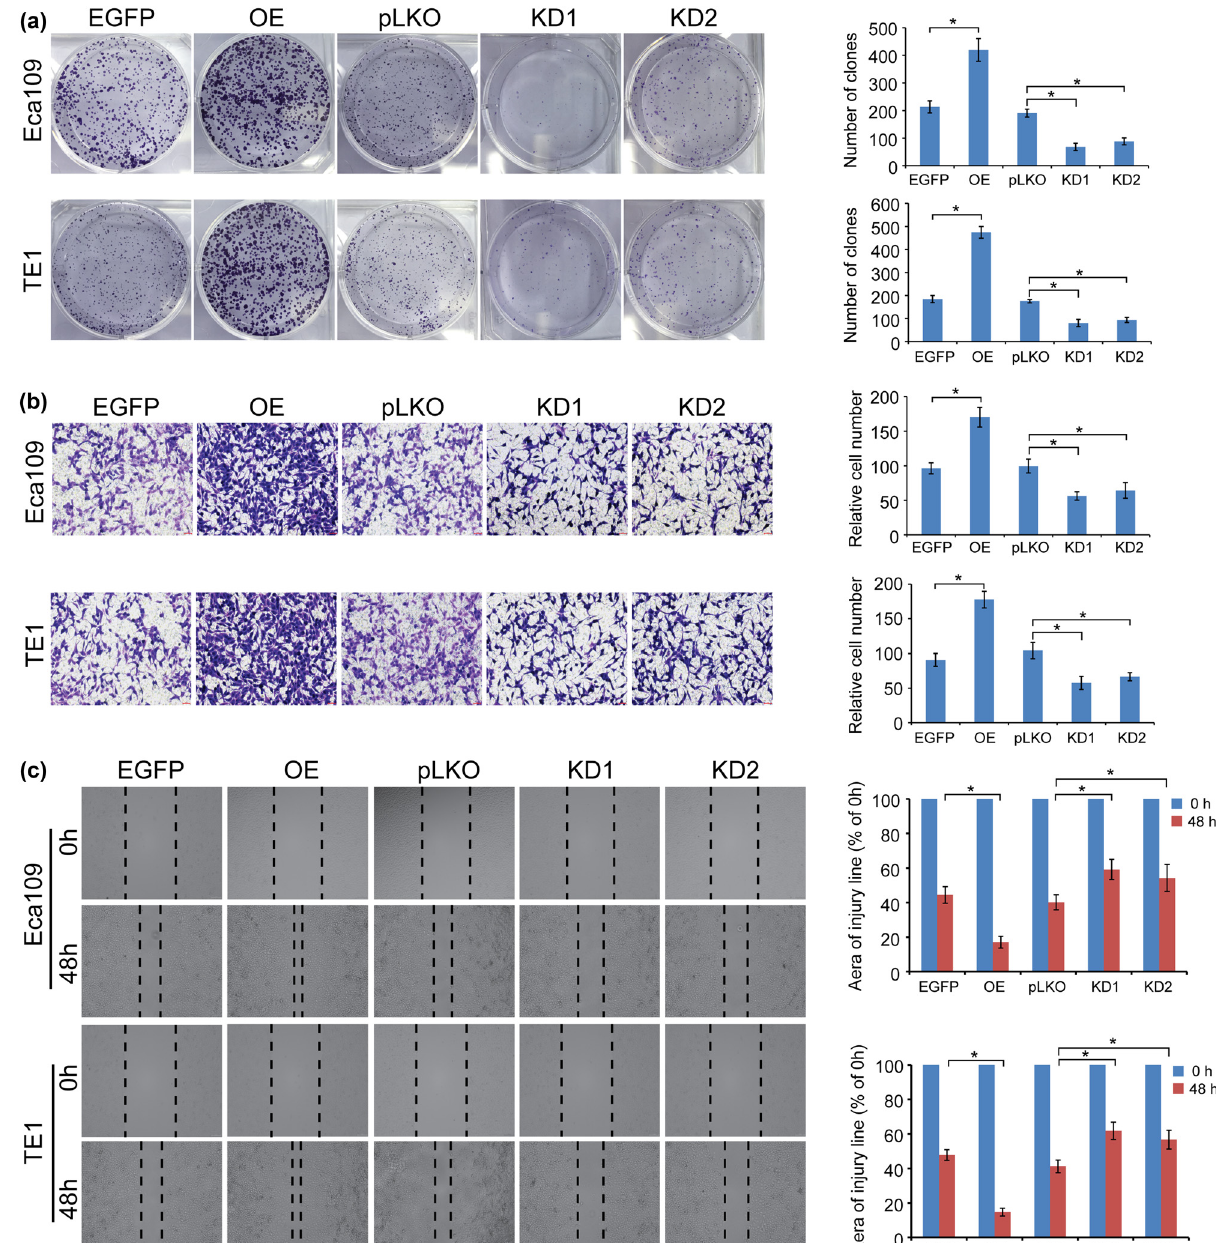
Figure 2: High expression of TET3 promotes the viability and motility of ESCC cells in vitro . ( a ) TET3 increased the colony formation ability of ESCC cells. ( b ) TET3 elevates the invasion abilities of ESCC cells that were evaluated by Transwell chamber assays. ( c ) Cell wound - healing assays were conducted to measure the migration potential of ESCC cells. * P <